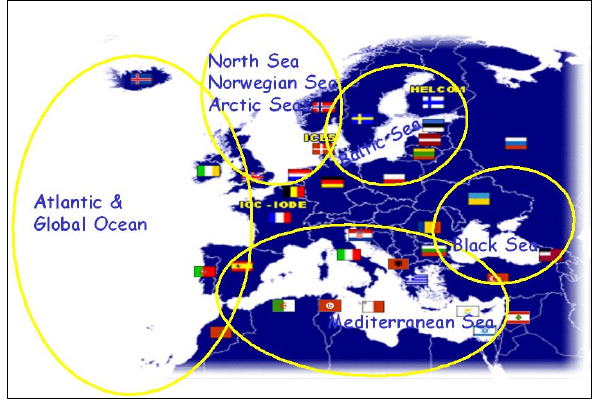
Fig. 1. Participating countries and international organizations in SeaDataNet. The yellow ellipses indicate regional areas of